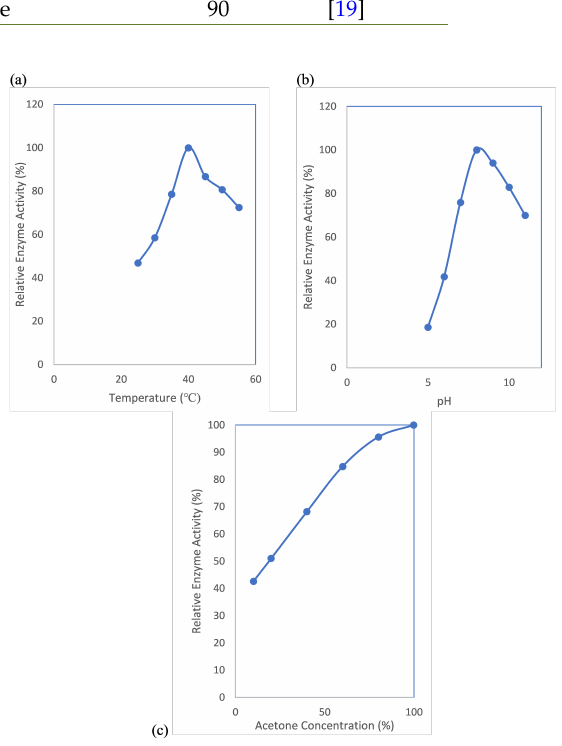
Fig. 1. (a) Optimum temperature, (b) pH and (c) acetone concentration on ANAE